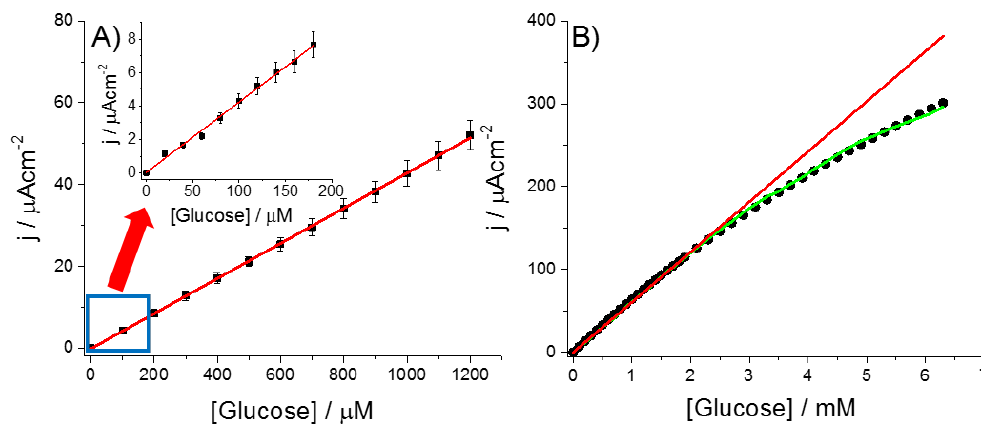
Figure 5. Current outcome obtained by successive additions of glucose in a stirred solution (10 mL) of 100 mM PB, pH 7, at 0.2 V (vs. Ag), using a GOx-PtNPs-PAA-aSPCE. Range of glucose concentration: ( A ) 100−1200 µM; inset of ( A ), 20−200 µM; and ( B ) 0.1−6.5 mM. The experimental data of I vs. time from Figure 5B are shown in Figure S5 (Supplementary Material).